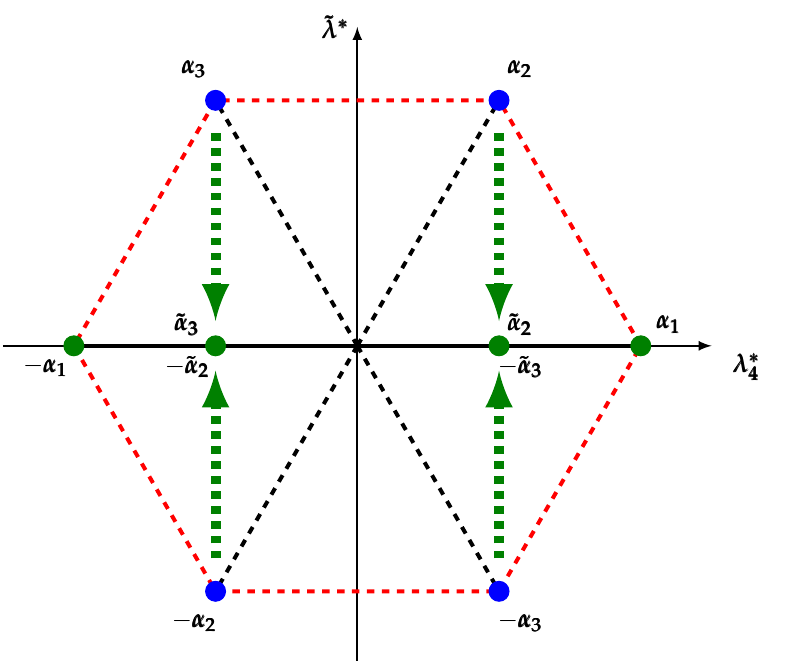
Figure 3. The non-vanishing roots of the non-split